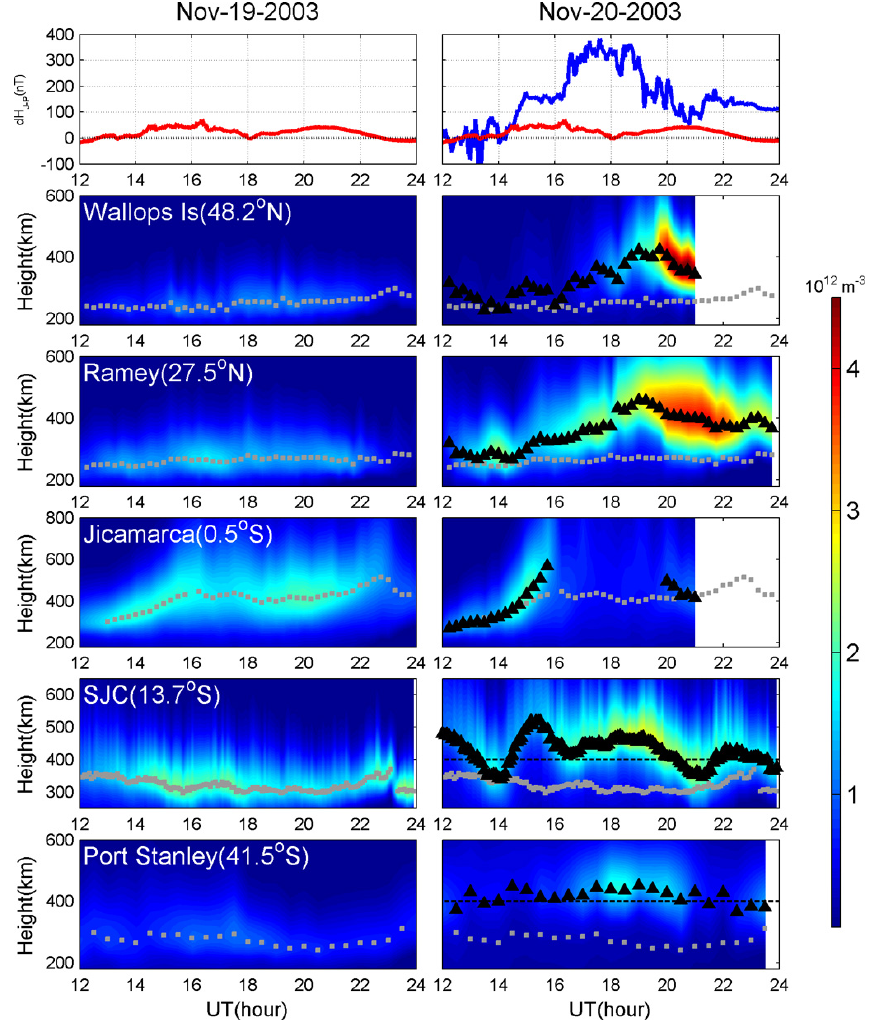
Fig. 2. Electron density profile variations as a function of time for the Latin America sector: (left) quiet day 19 November and (right) 20 November 2003 data. The station name and geomagnetic latitude are labeled on the top of each panel. The F2 layer peak heights are marked by squares for the quiet day and by triangles for the storm day. The horizontal dotted line denotes the altitude of 400km. The top two panels show dH J-P for the quiet day (left and red) and the storm day (right and